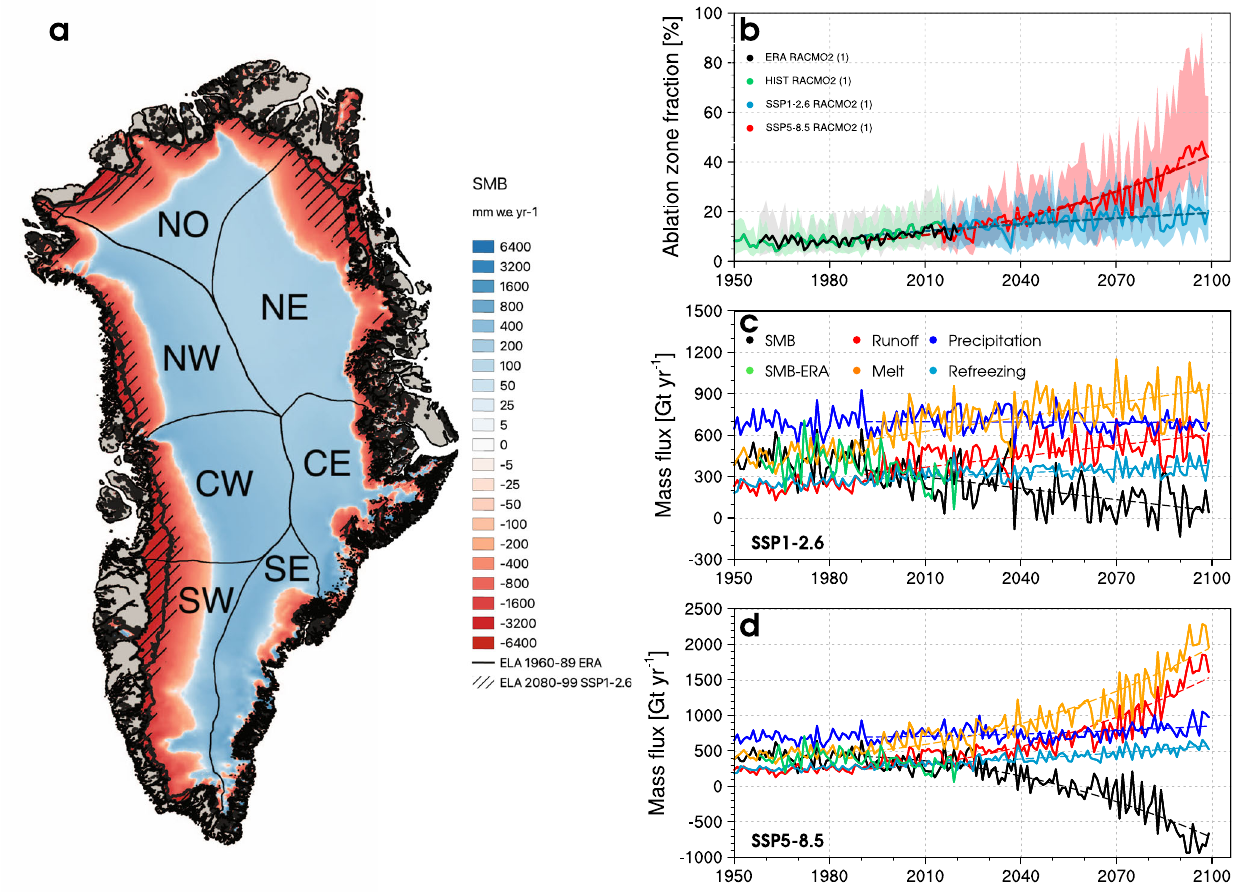
Fig. 1 | GrIS SMB under low and high-end warming by 2100. a Downscaled GrIS surface mass balance(SMB)from CESM2-forced RACMO2.3p2 at 1 kmunder SSP5- 8.5in2080 – 2099. Blackcontour andhatching outline the equilibriumline altitude (ELA; SMB=0) for the historical period 1950 – 1990 and for SSP1-2.6 in 2080 – 2099 respectively. The GrIS is divided in seven sectors 7 including north (NO), northwest (NW), northeast (NE), central west (CW), central east (CE), southwest (SW) and southeast (SE). b Time series of GrIS area fraction situated in the ablation zone (SMB < 0) from CESM2-forced RACMO2.3p2 for the historical period (1950 – 2014),